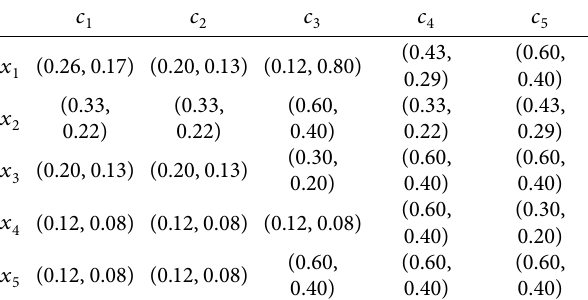
Table 2: Interval fuzzy number